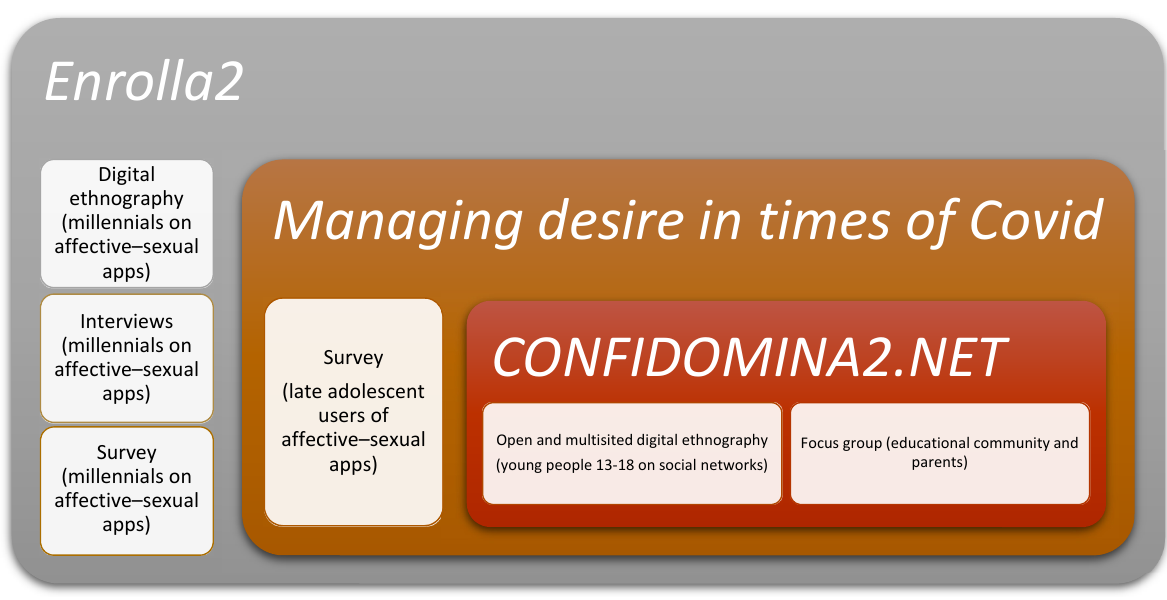
Figure 1. Methodological work structure. Prepared by the authors.